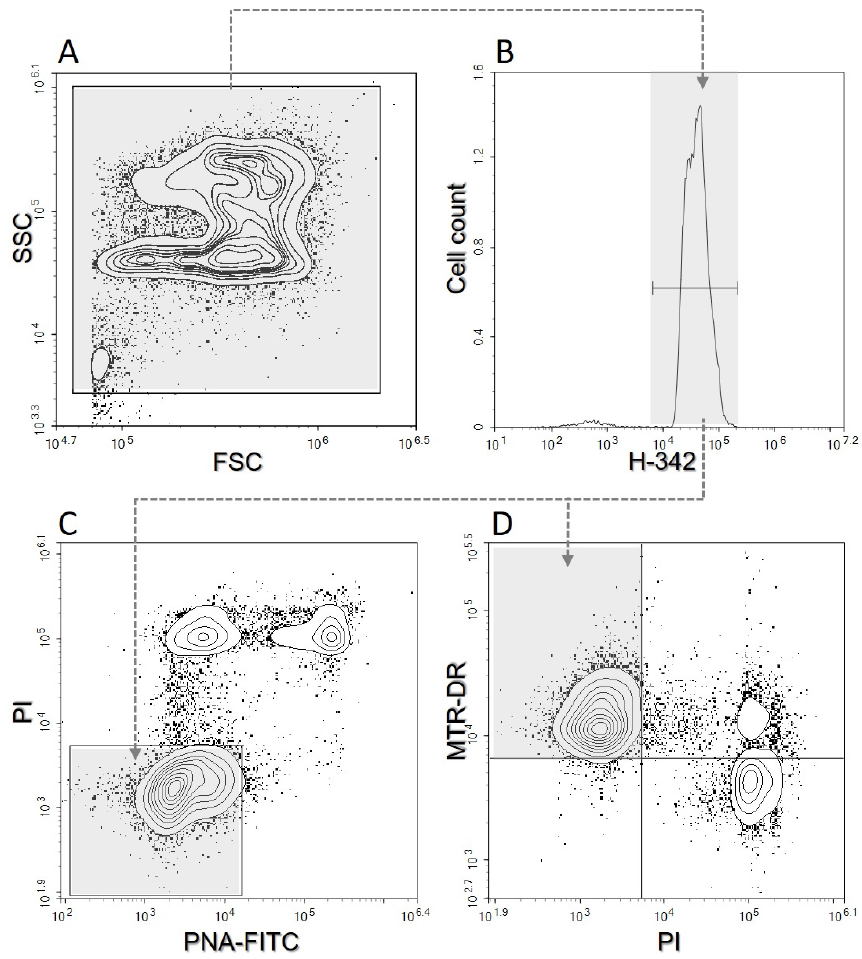
Figure 1. Illustration of the flow cytometric gating strategy. ( A )—Side scattering vs. forward scattering. ( B )—Cell count vs. Hoechst-33342 (H-342). ( C )—Propidium Iodide (PI) vs. lectin PNA (PNA-FITC); the PAI (plasma membrane and acrosome intact sperm) region is shown in grey. ( D )— MitoTracker™ Deep Red (MTR-DR) vs. PI; the MMP (mitochondrial membrane potential) region is shown in grey.